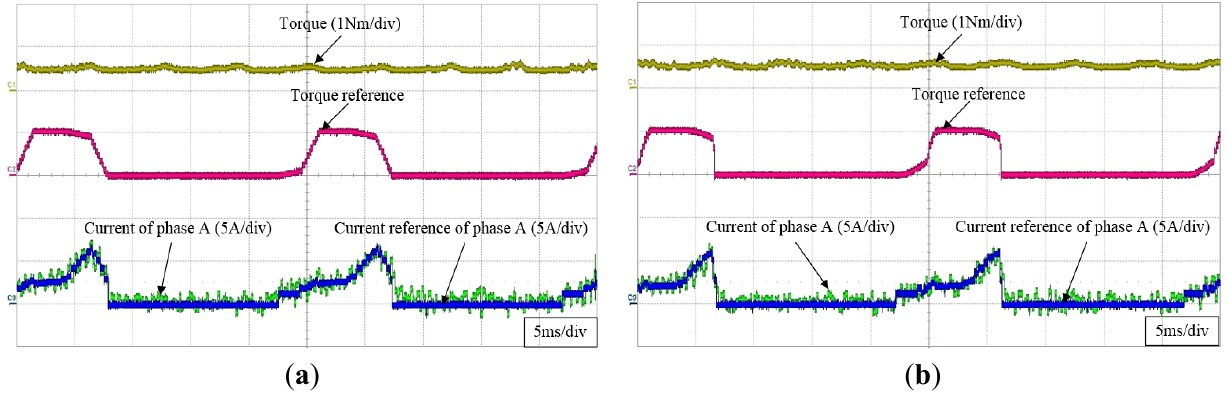
Figure 15. Experiment results at 300 rpm: ( a ) asymmetric TSF; ( b ) non-unity TSF.